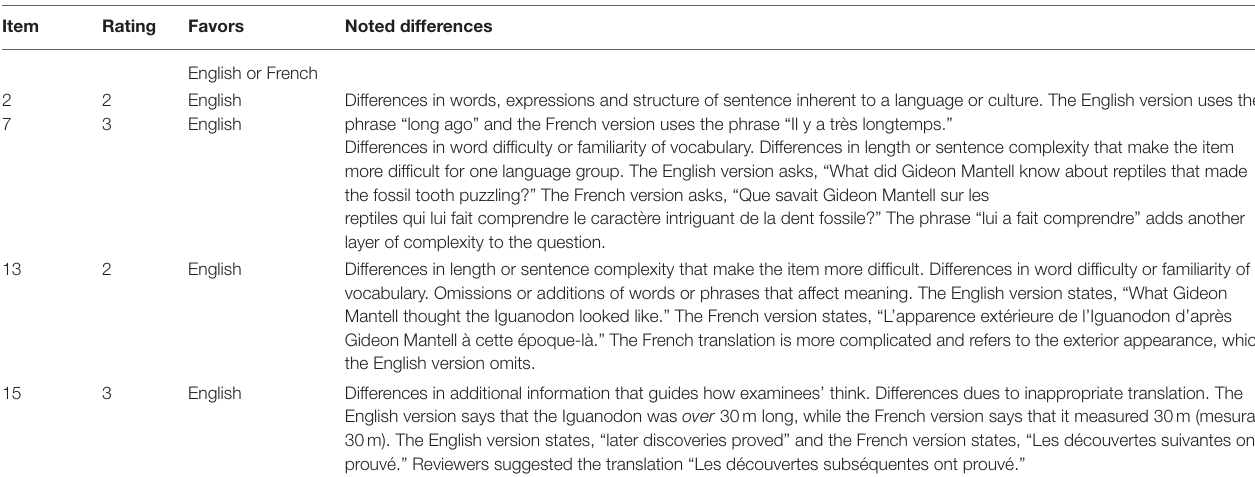
TABLE 8 | Passage 4 “The Giant Tooth Mystery” expert review ratings and noted